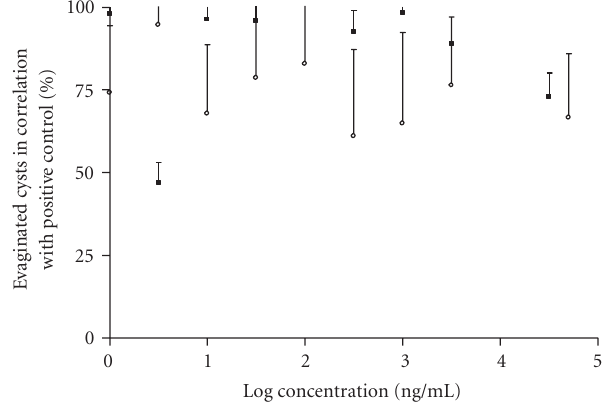
Figure 2: Percentage evaginated cysts in correlation whit positive control, against the log concentration of ivermectin and oxfenda- zole. The total number of cysts examined for the ivermectin study and the oxfendazole study was 750 for both drugs. The error bars represent standard deviation (S.D). (cid:2) : ivermectin; (cid:2) :